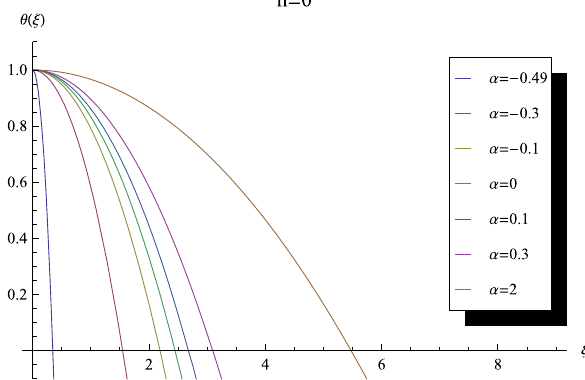
Fig. 4 Plots of the exact solutions for the case n = 0 for a few values of the parameter α